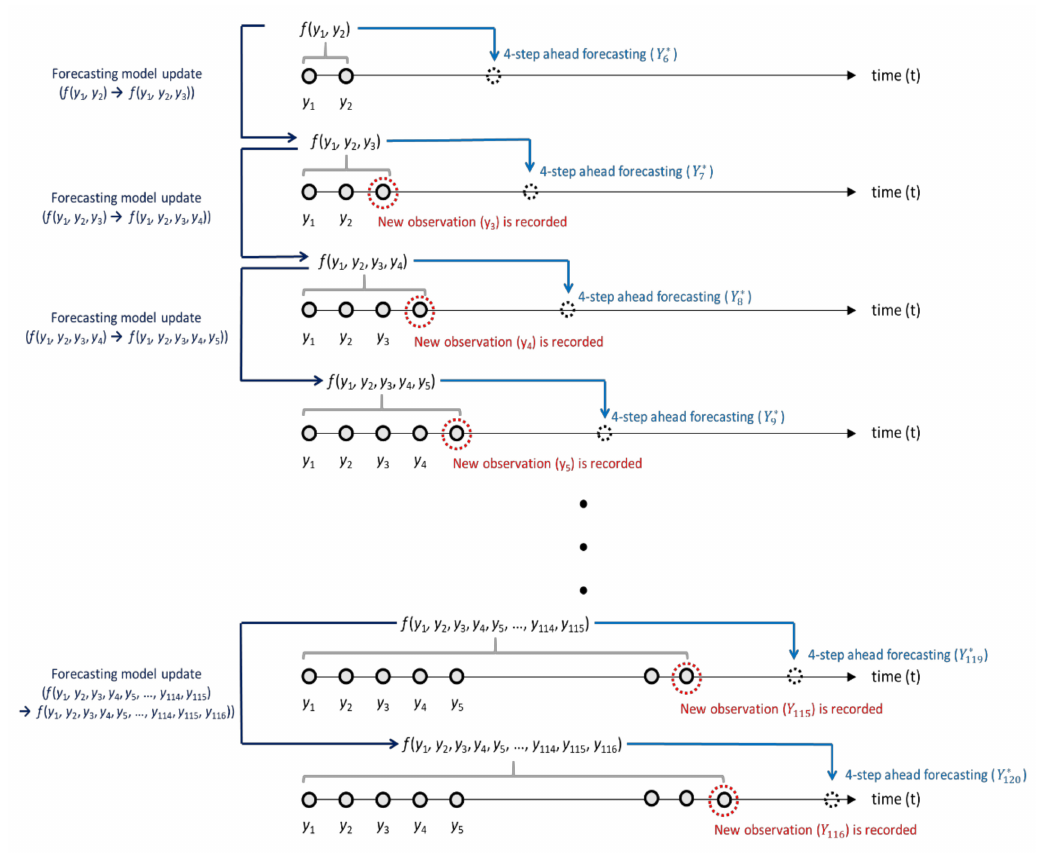
Figure 1. Graphical illustration of self-starting forecasting process when the forecasting window (s) and total time series length are 4 and 120,